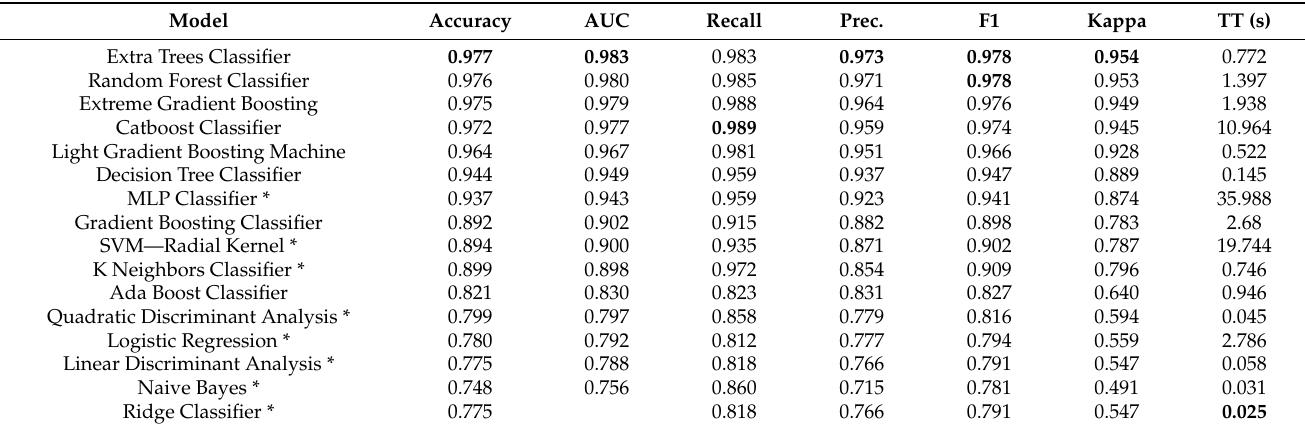
Table 4. Results of the model comparison carried out in this study on the test data.